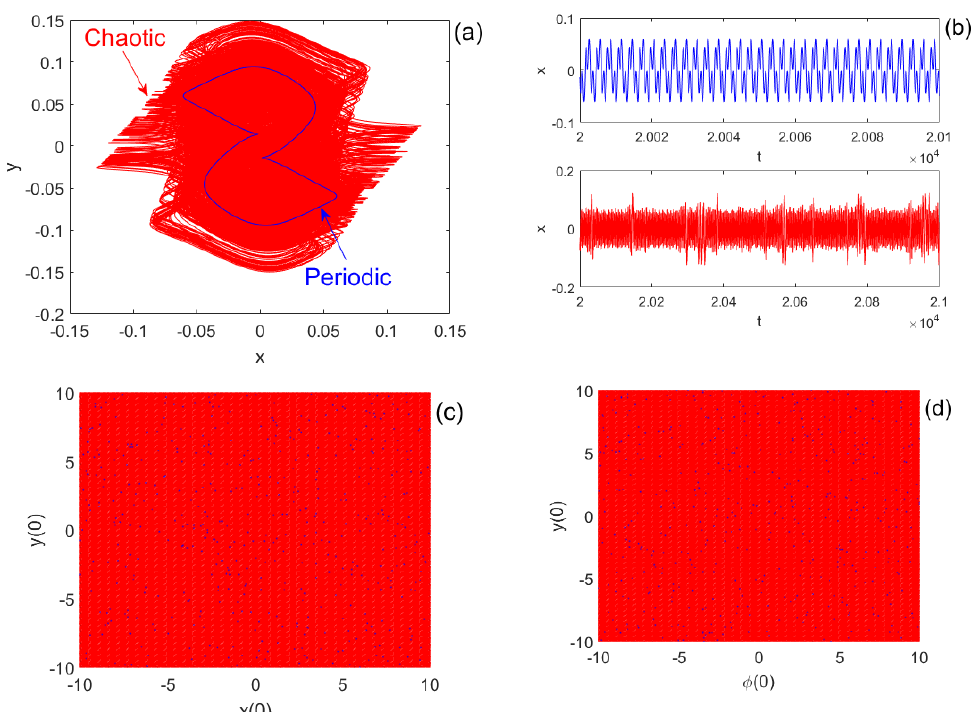
Figure 4. ( a ) Phase portraits of coexisting periodic and chaotic attractors and ( b ) their corresponding time series obtained with the initial conditions [0;0;0] for the chaotic behavior and [0;0;6] for the periodic behavior by fixing k 0 = 1.0. ( c , d ) represent the domain of the initial condition [x(0), y(0)] and [ ϕ (0), y(0)] associated with each of the coexisting